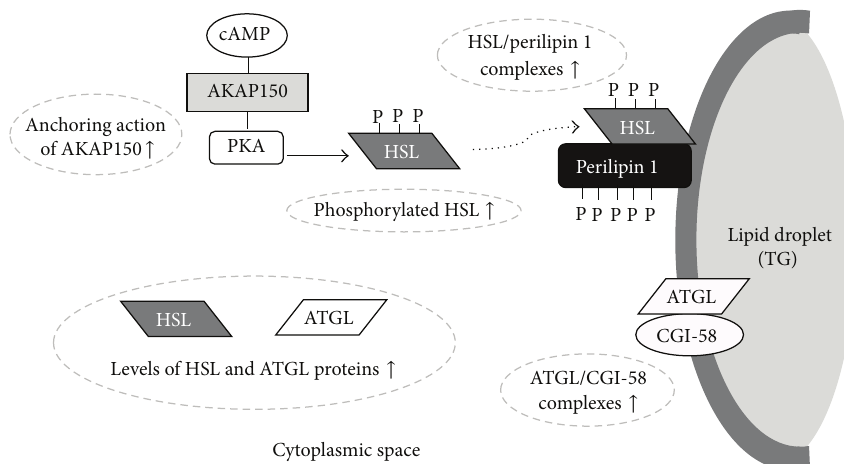
Figure 6: Summary of HE-induced adaptive changes of lipolytic molecules in white adipocytes. ET constantly promotes the expression levels of ATGL and HSL proteins. These conditions are likely to give rise to the stimulation of lipolytic responses through adaptive changes in molecules, such as increases in the anchoring action of AKAP150, higher levels of phosphorylated HSL, and augmentation of the formation of a complex of both HSL/perilipin 1 and ATGL/CGI-58 on the surface of lipid droplet. ↑ : upregulation of function and expression levels of each